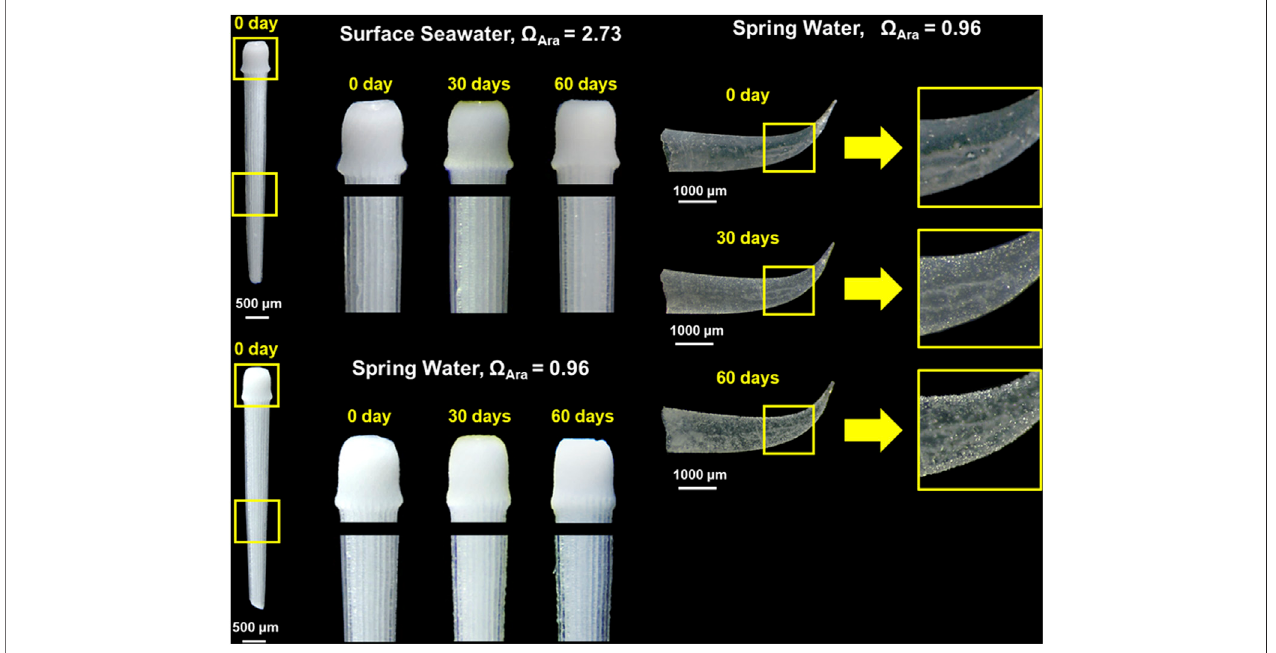
FIGURE7| Imagesof(bottomleft)thespineof H.pulcherrimus and(right)shellof C.virgula before(0 days)andafterincubationinthespringwateratstationS5with Ω (cid:2) 0.96 for 30 and 60 days. Seawater with Ω (cid:2) 2.73 incubated with (top left) the spine of H. pulcherrimus was used as the control. Ara Ara